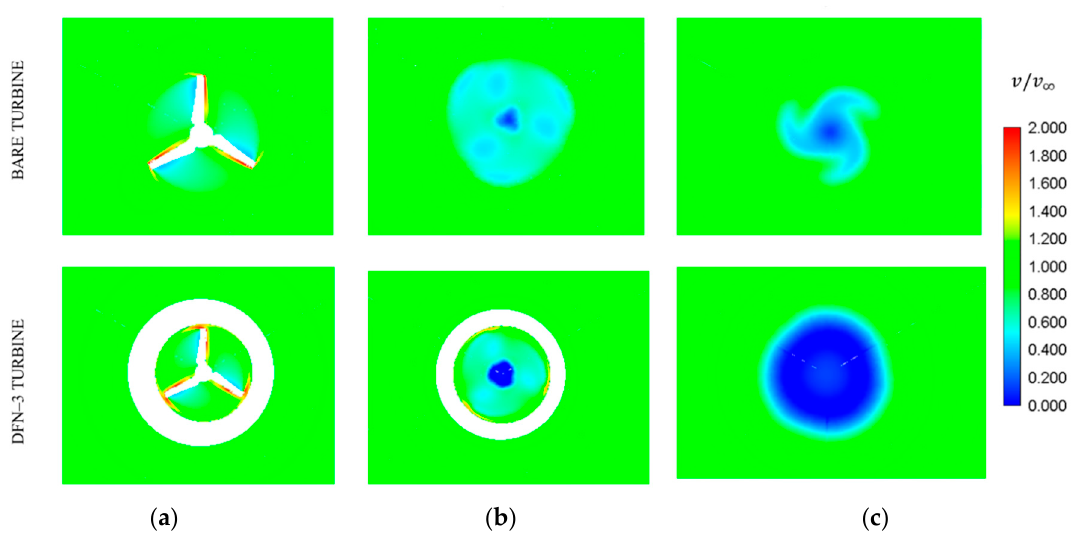
Figure 10. Comparison between CFD results and experimental data from ( a ) [10]; ( b ) [14].